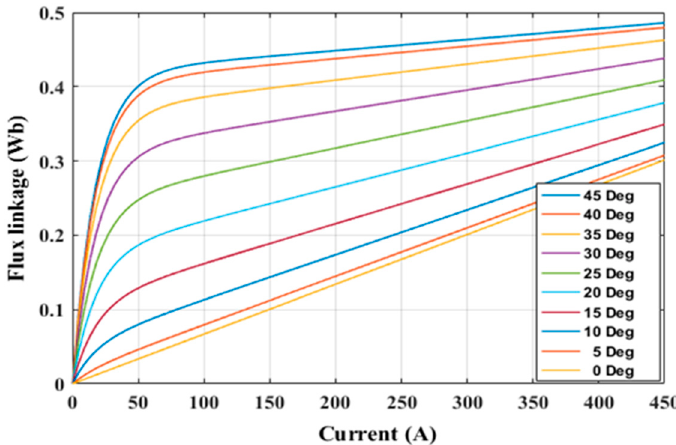
Figure 4. Magnetization curve for SRG model.